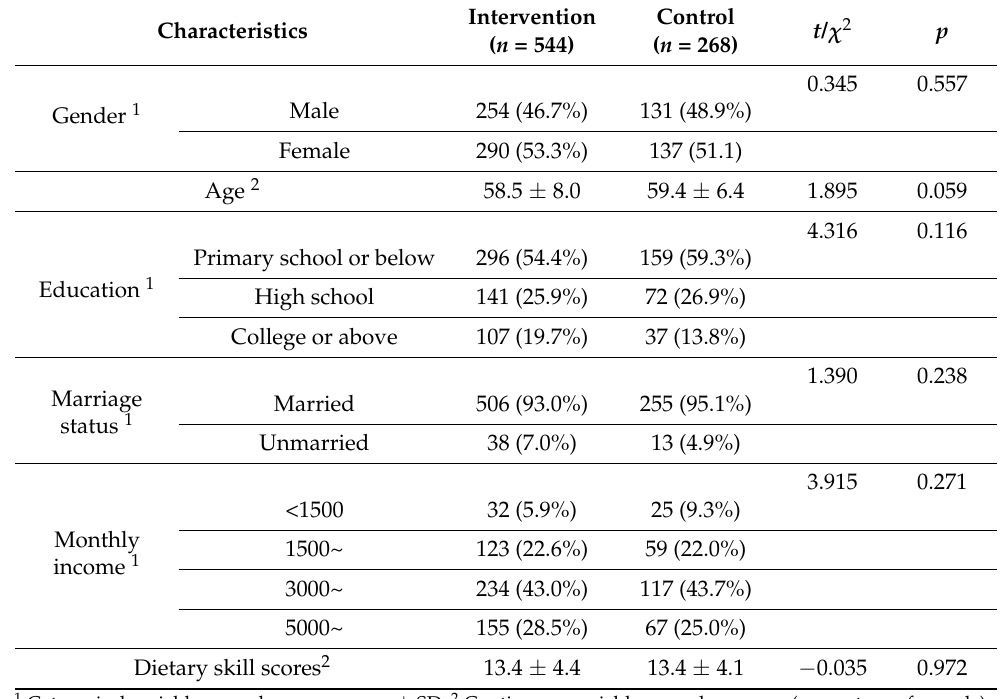
Table 1. Baseline characteristics of participants in the intervention group and control group. Characteristics ( n =